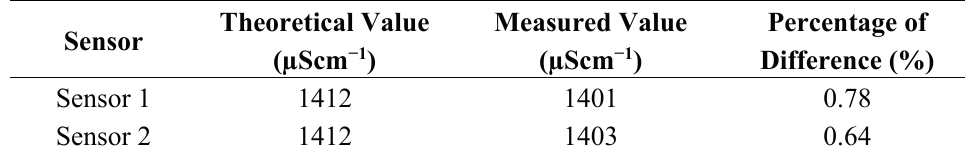
Table 2. Comparison between measured value and theoretical value of electrical